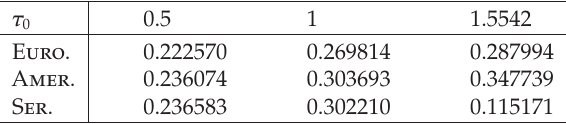
Table 2.9 . Put: Run 3; as in Table 2.7 but S D = 0 . 16, and σ = 0 . 25. 0